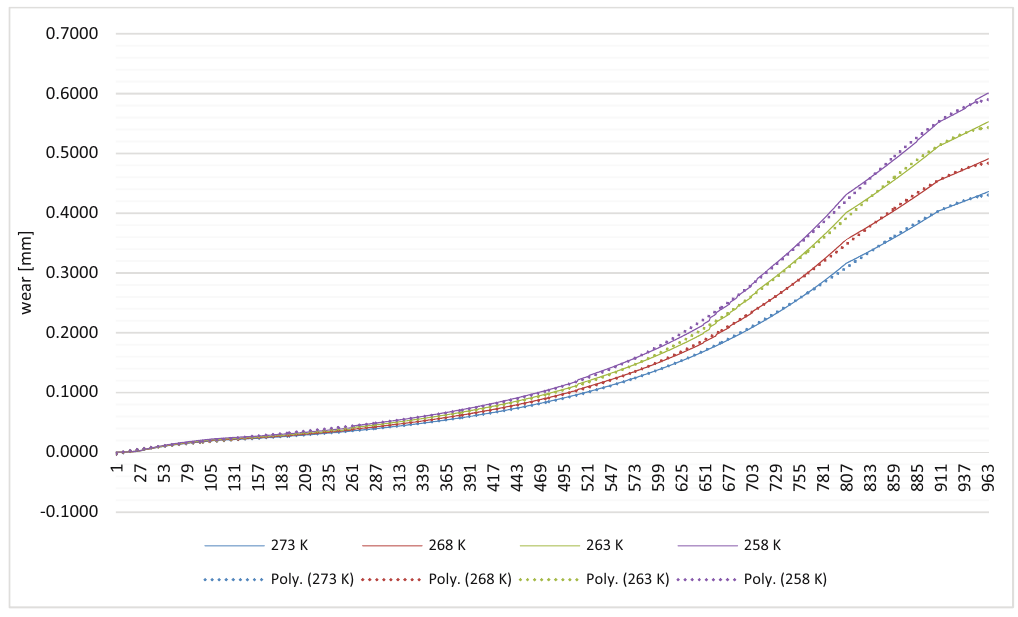
Figure 4: Average of the maximum wear of cylinder liners.